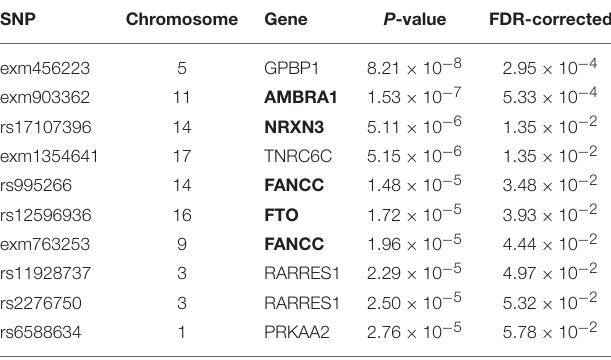
TABLE 2 | Top ten SNPs associated with angle of deformation